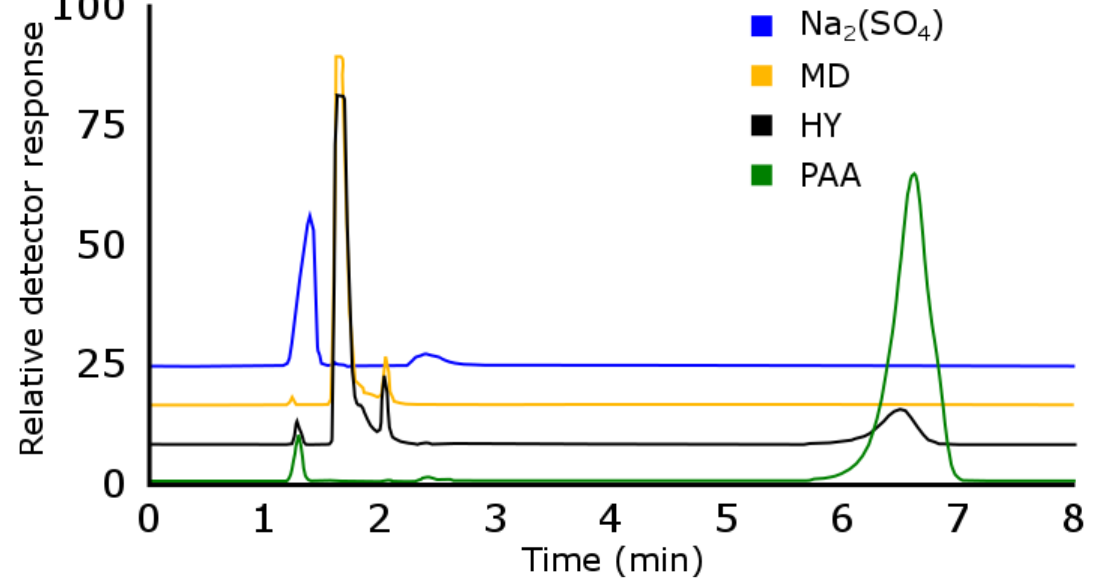
Figure 3. Overlay of Extended Polar Selectivity (EPS) Reversed-Phase Liquid Chromatography (RPLC) chromatograms of Na 2 (SO) 4 , HY, PAA and MD samples (1 mg / mL). Column: Platinum EPS C18 (250 × 4.6 mm i.d., 5- µ m particles); mobile phase A: 100% H 2 O (0.1% FA); mobile phase B: 100% acetonitrile (ACN) (0.1% FA); flow rate: 2 mL / min; gradient: 3–30% B, (3 to 7 min); detection: